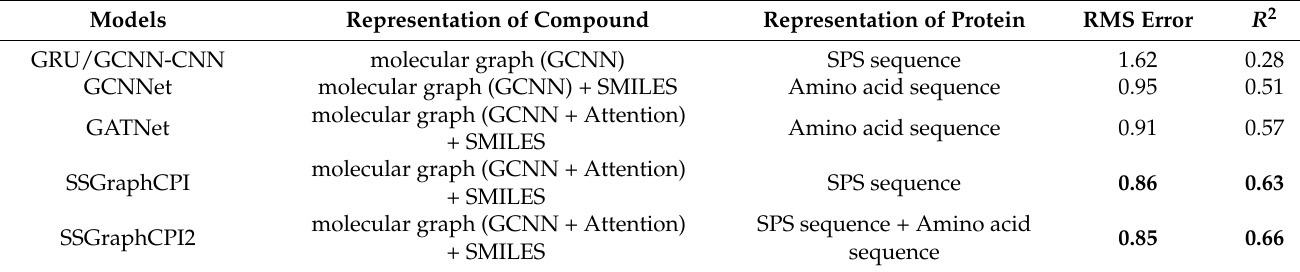
Table 1. RMS errors for different models on the Test dataset.